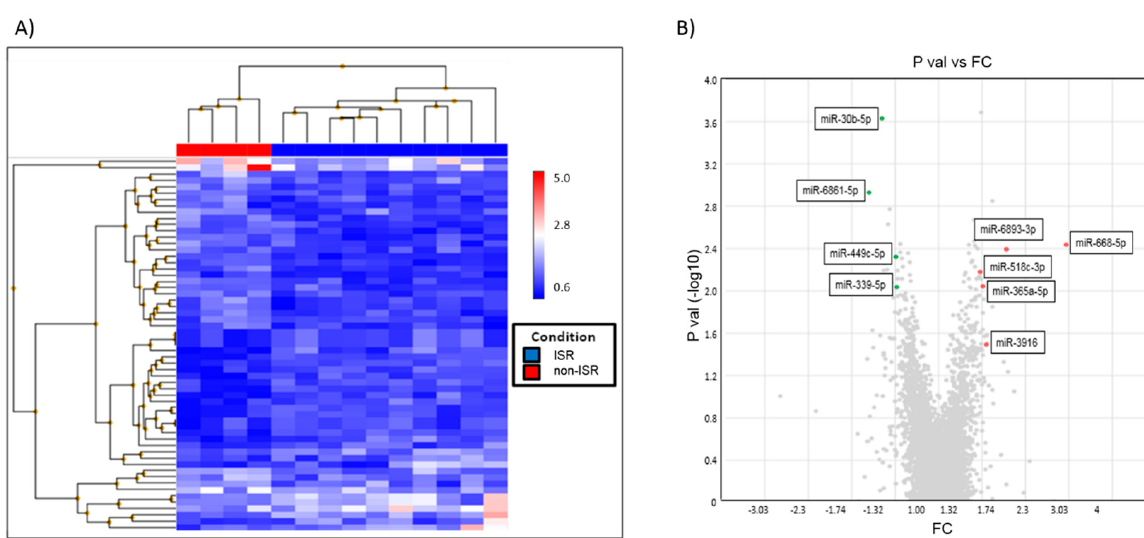
Figure 4. Microarray analysis of the expression of miRNAs in ISR as compare to non-ISR patients. ( A ) Hierarchical clustered sample-centric heat-map analysis of the Δ Ct value of differentially expressed miRNAs in ISR (red) and non-ISR patients (blue). Distance was measured by Pearson’s correlation. ( B ) Volcano Plot showing differentially expressed miRNAs between non-ISR and ISR are represented by splashes which show fold-change (FC) values and p values of miRNAs. Green splashes indicate significantly upregulated miRNAs. Red splashes indicate significantly downregulated